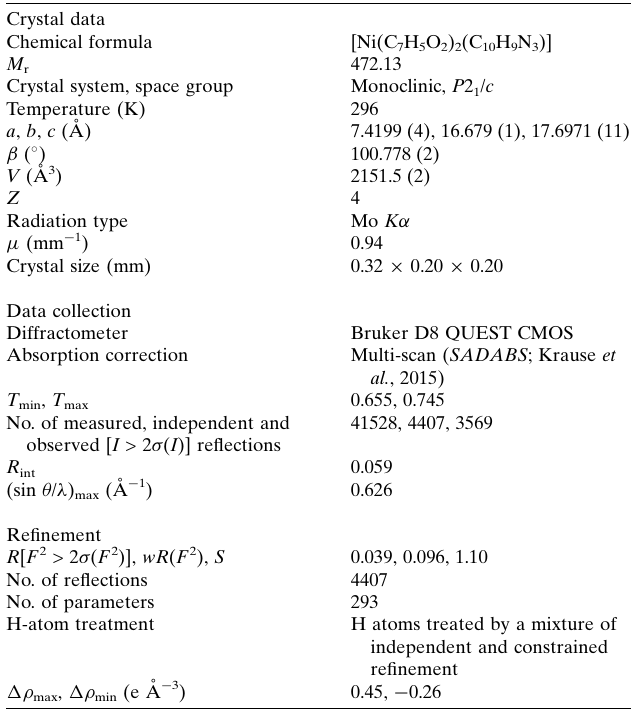
Table 3 Experimental